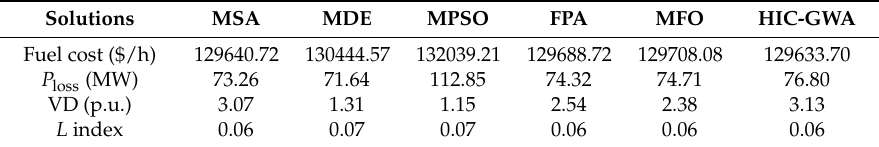
Table 16. Comparison of HIC-GWA results with the literature for case study 11.